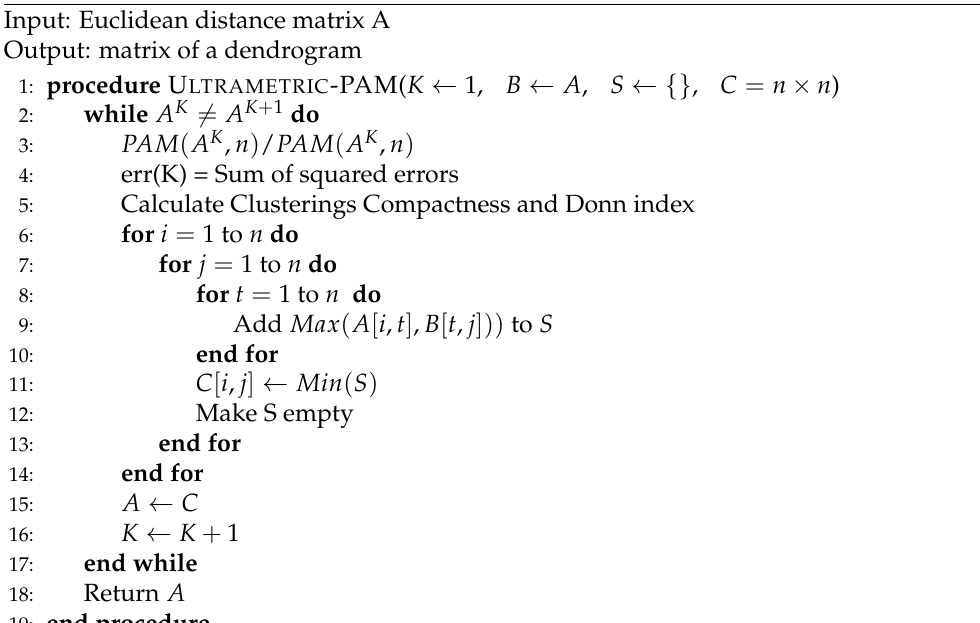
Algorithm 4 generates the cluster centroids and BoW representation of the training and testing data required by the FABMAP algorithm. To train the Chow-Liu tree in the FABMAP algorithm, we use the BoW representation and the clustering centroid of the training data set. In the next section, we present the clustering evaluation metrics used in performance benchmarks. Algorithm 1 (Ultrametric-PAM) Runs PAM with the transformed distance matrices